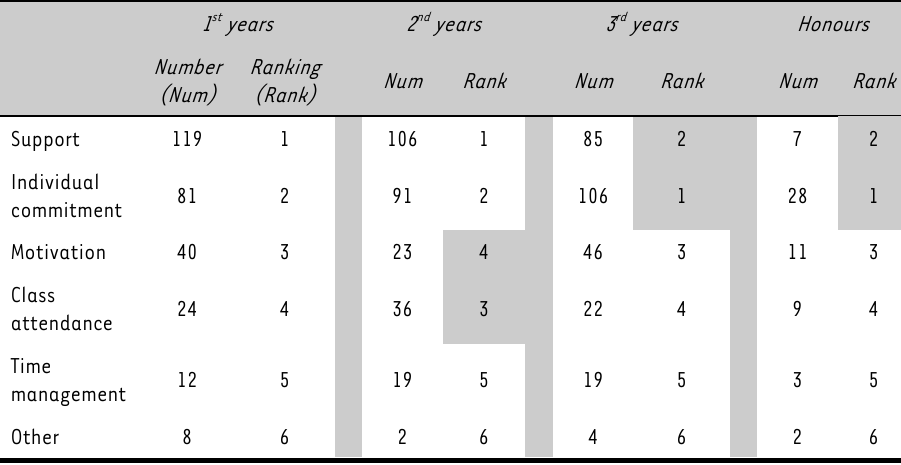
Factors promoting own success split between academic